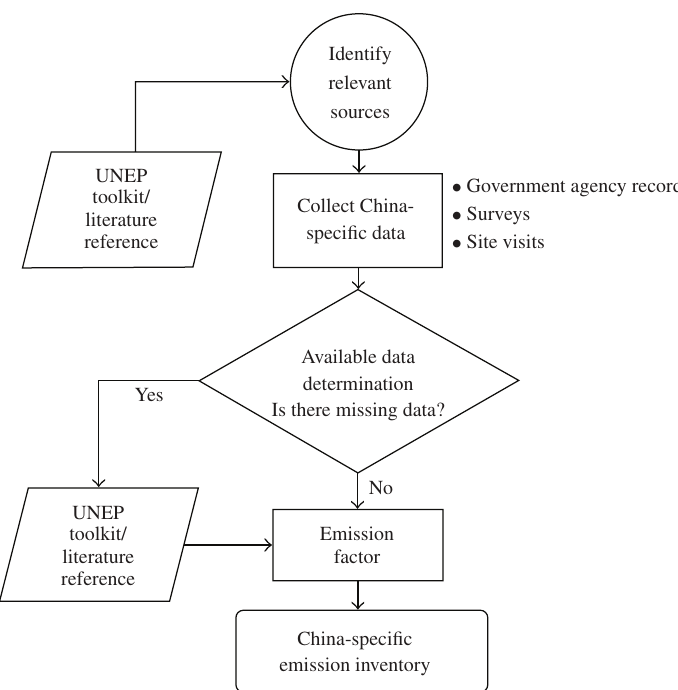
FIGURE 2: Flow chart diagram of China dioxin emission inventory methodology